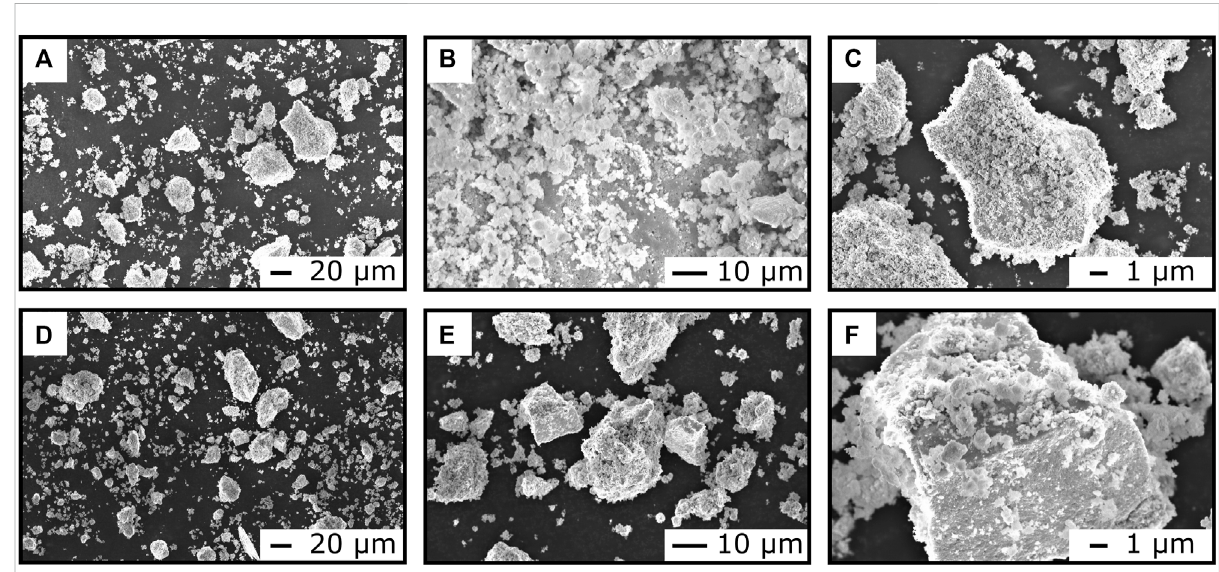
FIGURE 2 Top-view SEM images at different magni fi cations of HEO-La (A – C) and HEO-Sr (D – F) prepared by ball